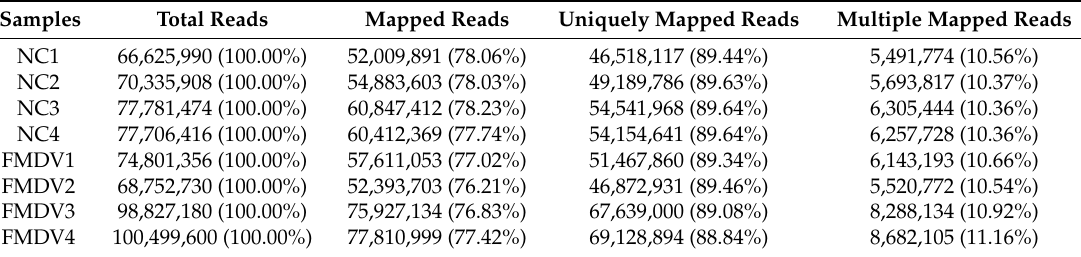
Table 2. Alignment results.